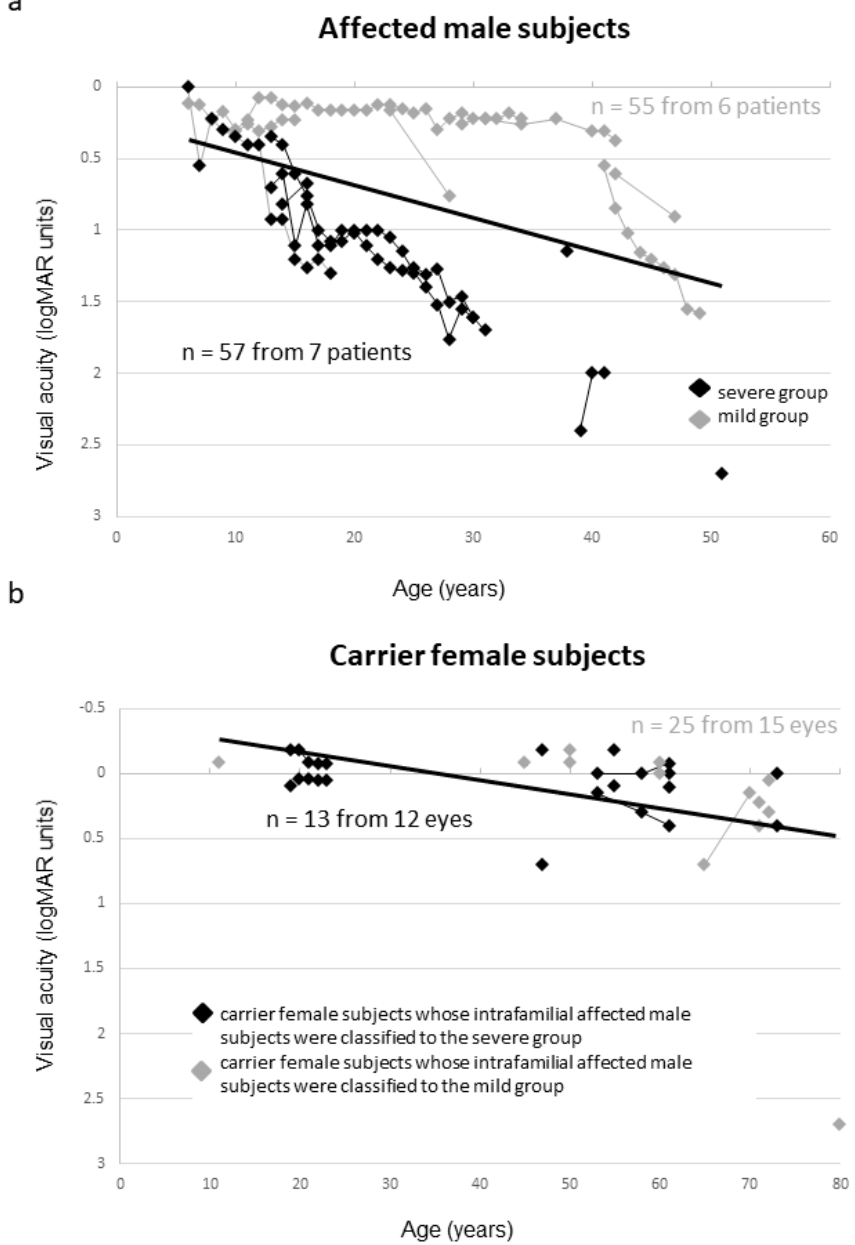
Figure 7. Association of the severity between affected male and carrier female subjects. The data from the same subject are indicated using bars connecting the points. ( a ) Black and gray diamonds indicate the severe and mild phenotypic groups, respectively. Affected male subjects were divided into two groups according to their phenotypic severity. Visual acuity above the regression line was defined as mild (mild group). Conversely, visual acuity below the regression line was defined as severe (severe group). ( b ) The data of carrier female subjects whose intrafamilial affected male subjects were classified into the severe group are indicated with black diamonds. Conversely, the data of carrier female subjects whose intrafamilial affected male subjects were classified into the mild group are indicated by gray diamonds.